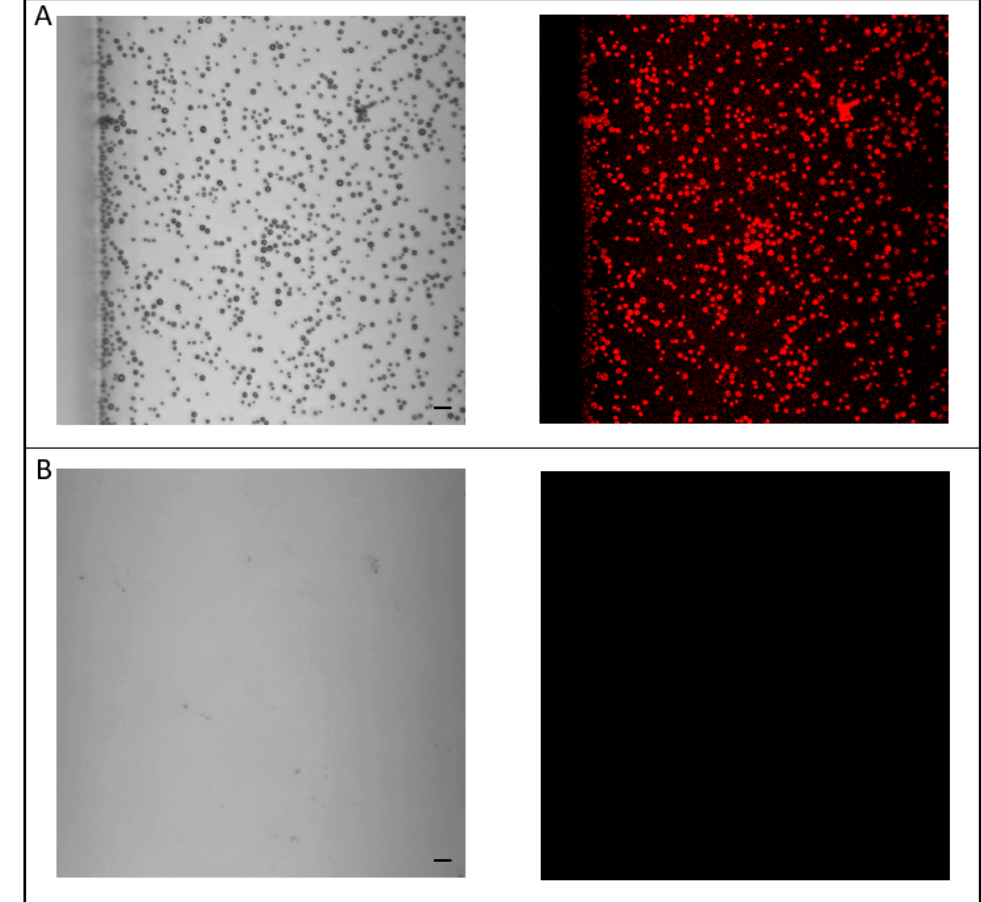
Figure 3. Bright field ( left ) and CLSM images ( right ) of ( A ) RBITC MBs into the microchannel Vena8 Endothelial + (the edge of the channel is visible on the left side); ( B ) images at the bottom of the same channel showing the lack of capsules and debris from RBITC MBs. Scale bar 10 μ m.